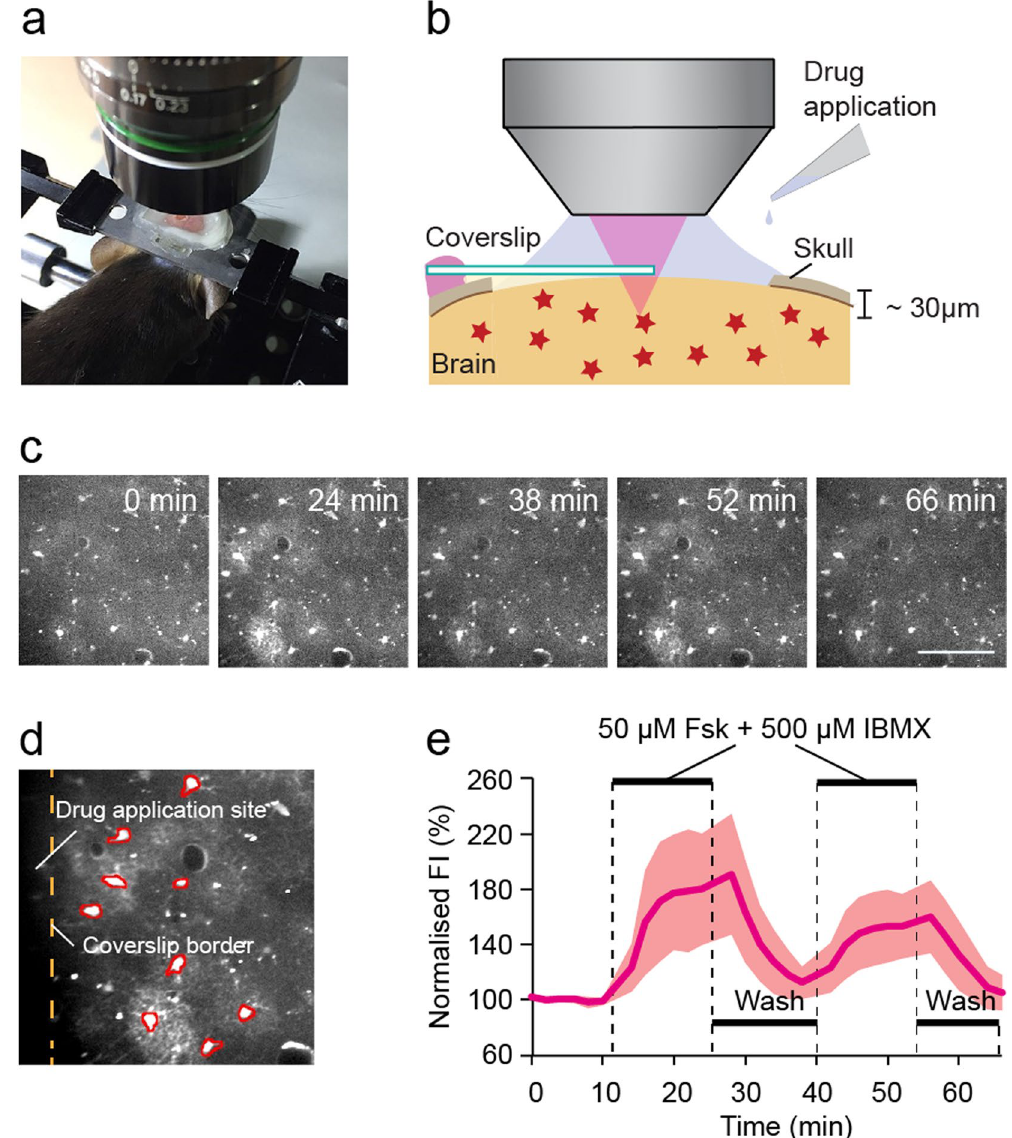
Figure 4. In vivo imaging of cerebral cortical astrocytes using Pink Flamindo. ( a ) Image showing the experimental setup of a mouse under anaesthesia, positioned under a two-photon microscope. ( b ) Schematic of the cranial window for in vivo two-photon imaging. ( c ) Sequential images of cortical astrocytes expressing Pink Flamindo during exposure to 50 μ M Fsk and 500 μ M IBMX. Scale bar represents 100 μ m. ( d ) Enlarged image of c (24 min) to indicate the regions of interest. Analysed cells are marked in red. Yellow dashed line indicates the coverslip border (see b ). Scale bar represents 50 μ m. ( e ) Population mean trace of fluorescence intensity for Pink Flamindo from the images shown in c . The topical application of Fsk, IBMX and compound washout (indicated by black horizontal bars) was repeated twice. The data represent the means ± standard deviation (n = 9